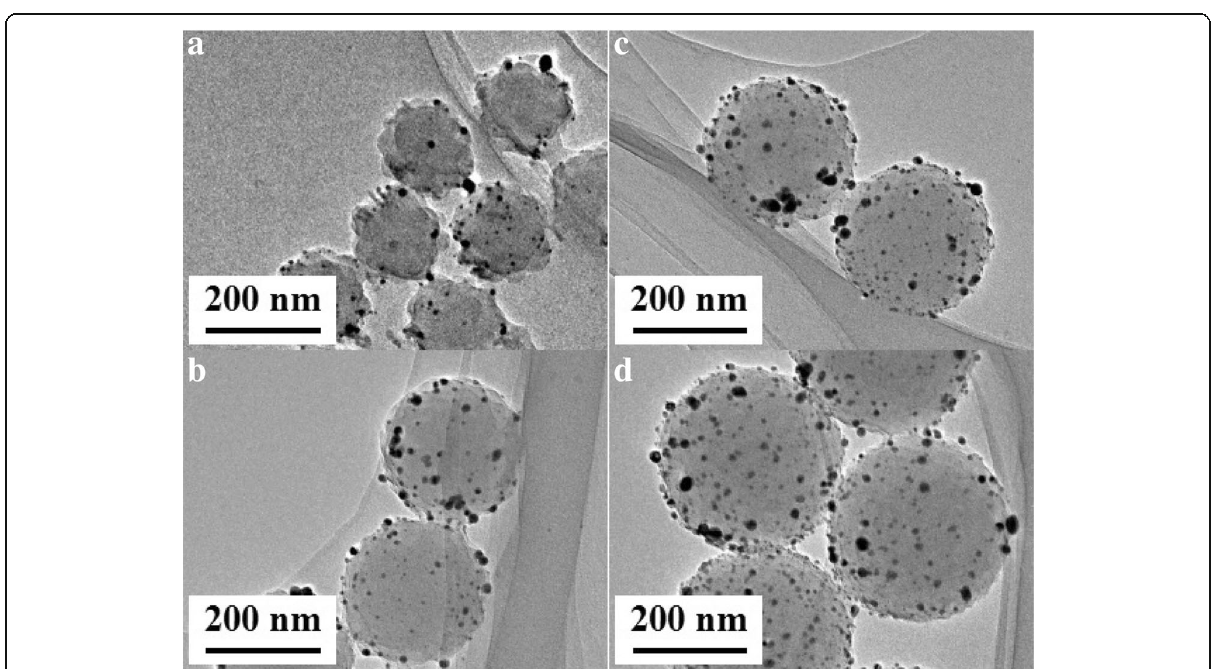
Fig. 6 TEM images of nAg@PSA nanocomposites. a – d , corresponding to nAg@PSA1 –